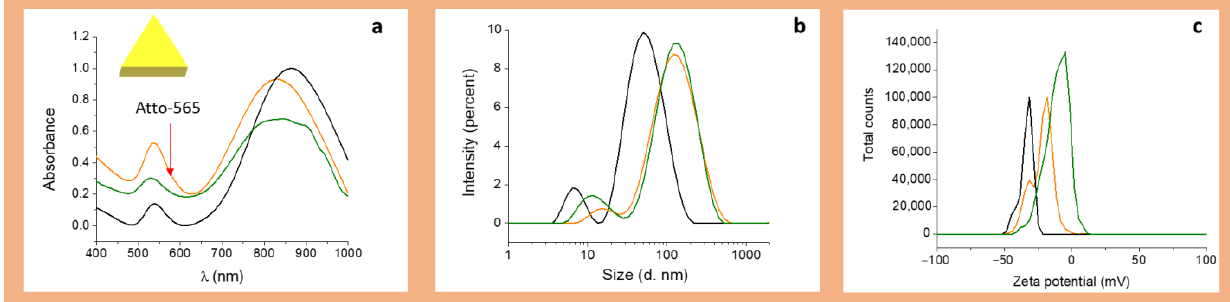
Figure 3. Characterization of BSA-A565-r 8 capped AuNPrs; black line AuNPrs, green line AuNPr-BSA, and orange line AuNPr-BSA-A565-r 8 . ( a ) UV-Vis-NIR spectra. The red arrow shows the presence of Atto-565. ( b ) Size distribution. ( c ) Zeta potential distribution. Acquired in PBS, pH = 7.